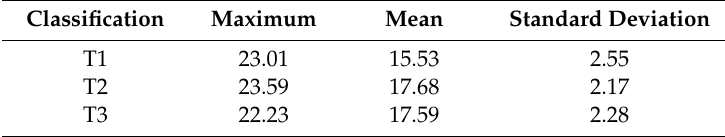
Figure 6. Results of ( a ) tillage depth for three-time repeated test, ( b ) overall tillage depth distribution ratio, and ( c ) overall pitch angle of moldboard plow according to tillage depth. Table 4. Descriptive statistics of measured tillage depth (cm) during the field